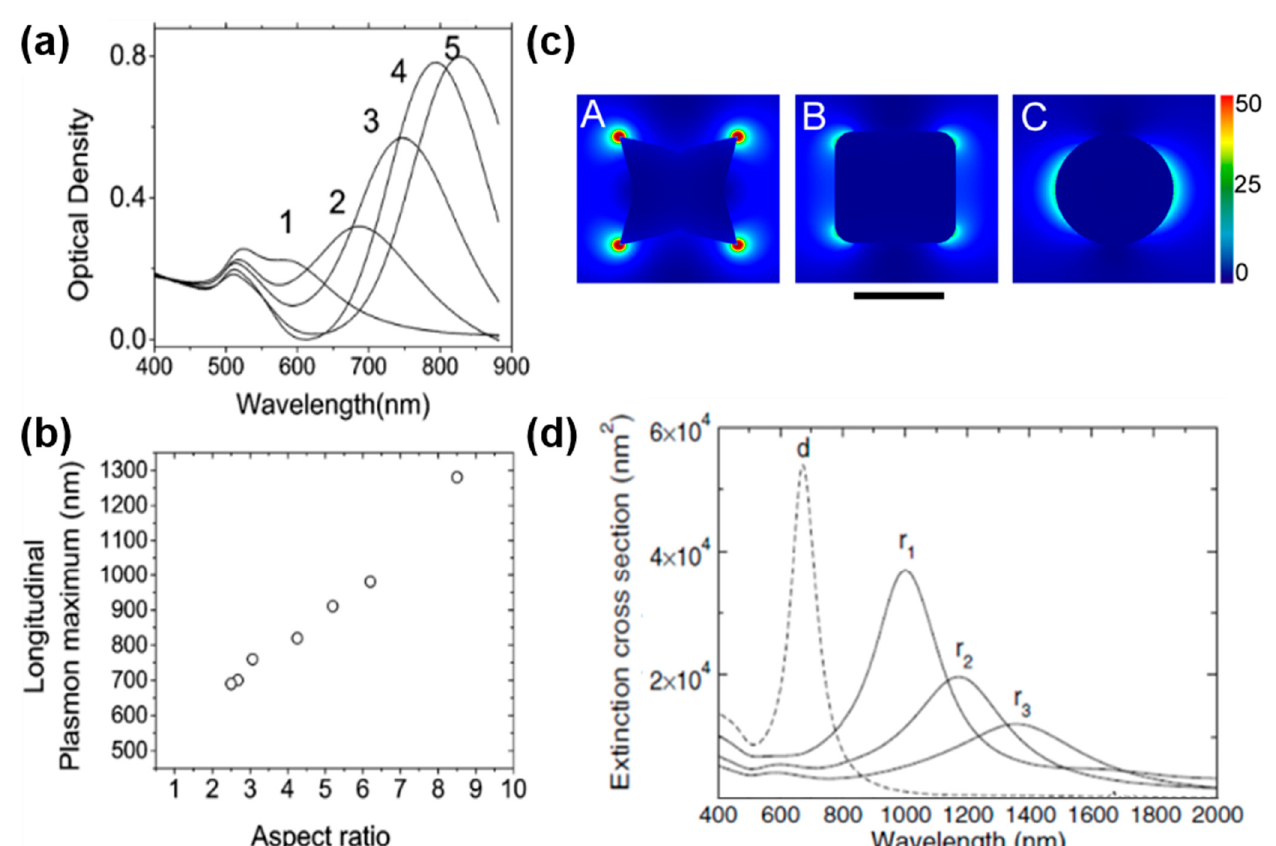
Figure 2. Anisotropic metal NPs. ( a , b ) Au NRs. ( a ) Visible-NIR spectra of five NR solutions with increasing aspect ratios, showing two distinct LSPR bands, one around 520 nm (transverse mode) and one at higher wavelengths (longitudinal mode). ( b ) Dependence of the longitudinal mode resonance wavelength as a function of the NR aspect ratio. ( c ) FDTD simulations of the near-field enhancements (E 2 ) of Au NPs with different shapes plotted for a concave nanocube (A), a nanocube (B), and a nanosphere (C) in air with 785 nm excitation wavelength. The scale bar is 100 nm. ( d ) Experimental extinction spectra of a Au nanodisk (d, dashed line) and nanorings (r, solid lines) with an outer diameter of 120 nm and different wall thicknesses (decreasing from r 1 –r 3 ). ( a , b ) Reprinted with permission from ref. [42]. Copyright 2003 American Chemical Society. ( c ) Reprinted with permission from ref. [45]. Copyright 2012 American Chemical Society. ( d ) Reprinted with permission from ref. [46]. Copyright (2003) by the American Physical Society.